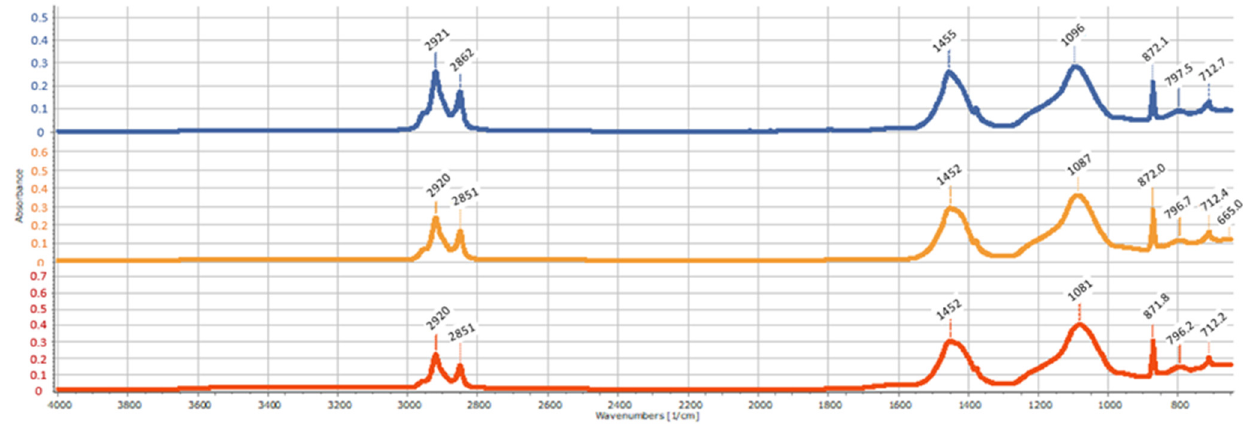
Figure 2. FTIR of RM EPDM, either original or extracted or after-SW. Blue line: original; orange line: extracted; red line: after SW.